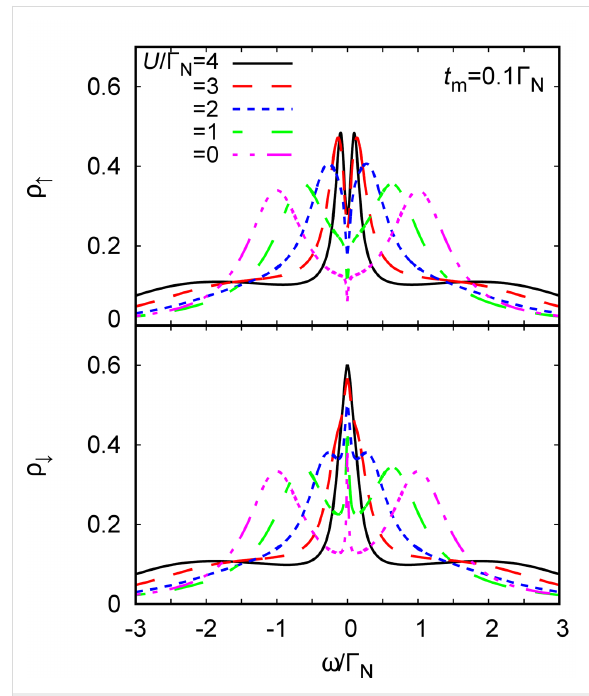
Figure 8: The polarized spectral function ρ σ ( ω ) obtained at zero tem- perature for the half-filled QD ( ε = − U /2), Γ S = 2 Γ N , t m = 0.1 Γ N and several values of the Coulomb potential U (as indicated). Energies are expressed in units of Γ N .